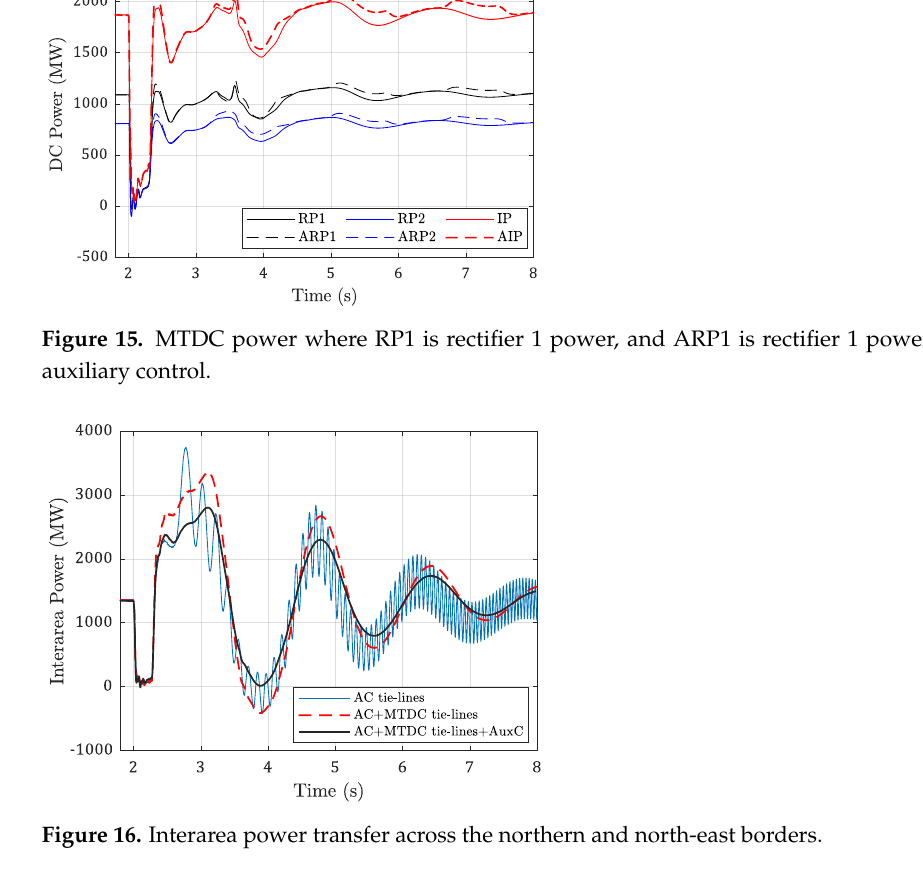
Figure 16. Interarea power transfer across the northern and north-east borders.